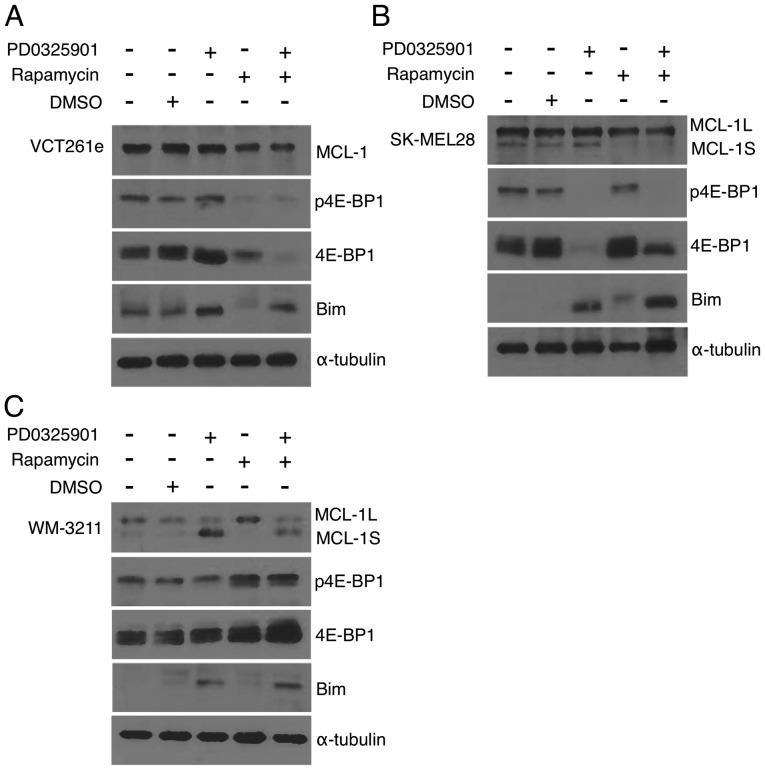
Treatment with PD0325901 and rapamycin alters the expression of pro-survival and pro-apoptotic proteins. MCL-1, phosphorylated 4E-BP1 (S65), total 4E-BP1, Bim, and α-tubulin western blots after dual combination treatment in vitro. (A) VCT261e canine AS cells treated with PD0325901 (40 nM) and rapamycin (10 nM) for 72 h. (B) SK-MEL28 cells treated with PD0325901 (5 nM) and rapamycin (6.25 nM) for 72 h. (C) WM-3211 cells treated with PD0325901 (200 nM) and rapamycin (50 nM).